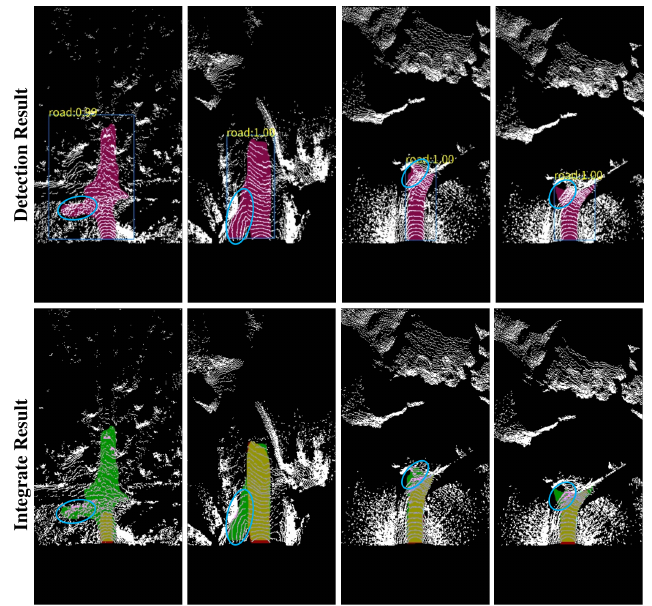
Figure 8. The upper row is the detection result of the original model, and the lower row is the result of multi-frame fusion. The error in the detection result of this frame is shown in the blue circle. The green plus yellow area is the detection result of this frame, and the red plus yellow area is the fusion result of this frame, which is also the final output result.